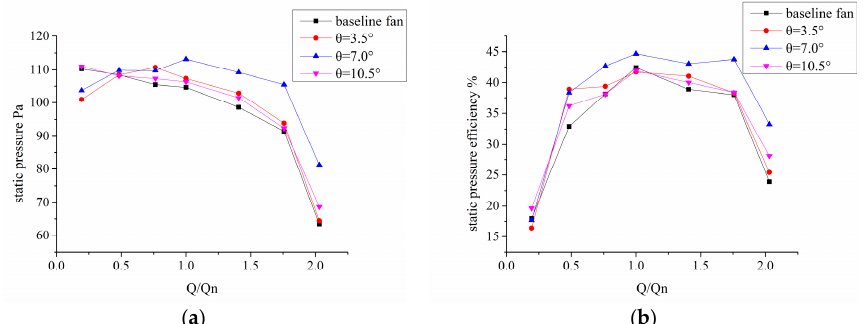
Figure 7. Performance curve for baseline model and fans with modified impellers: ( a ) static pressure–flow rate curve; ( b ) static pressure e ffi ciency–flow rate